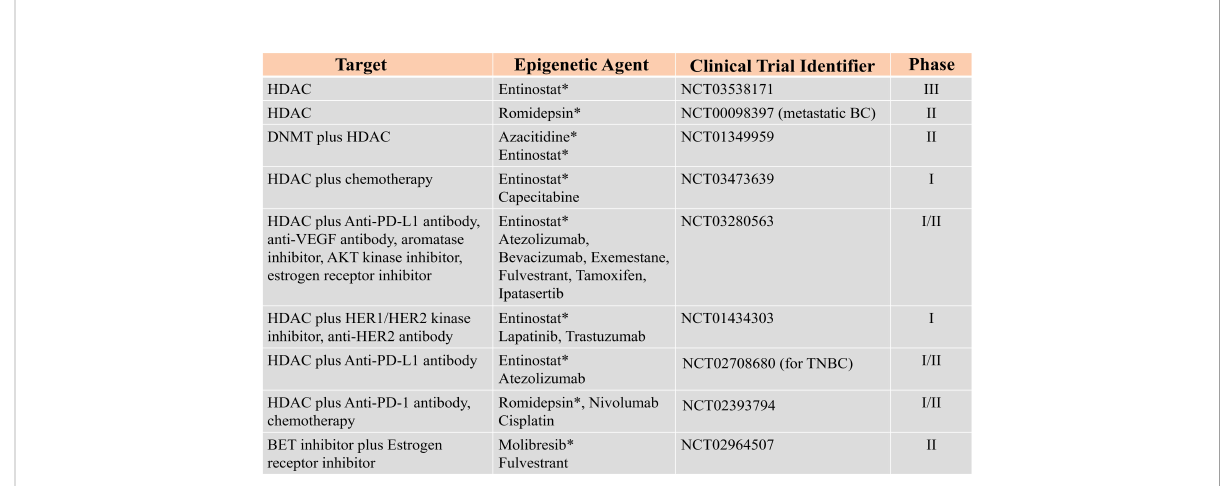
FIGURE 3 Epigenetic Targets and other combined inhibitors for breast cancer therapies under clinical trial. Data adapted from (154). Star (*) represents the speci fi c epigenetic